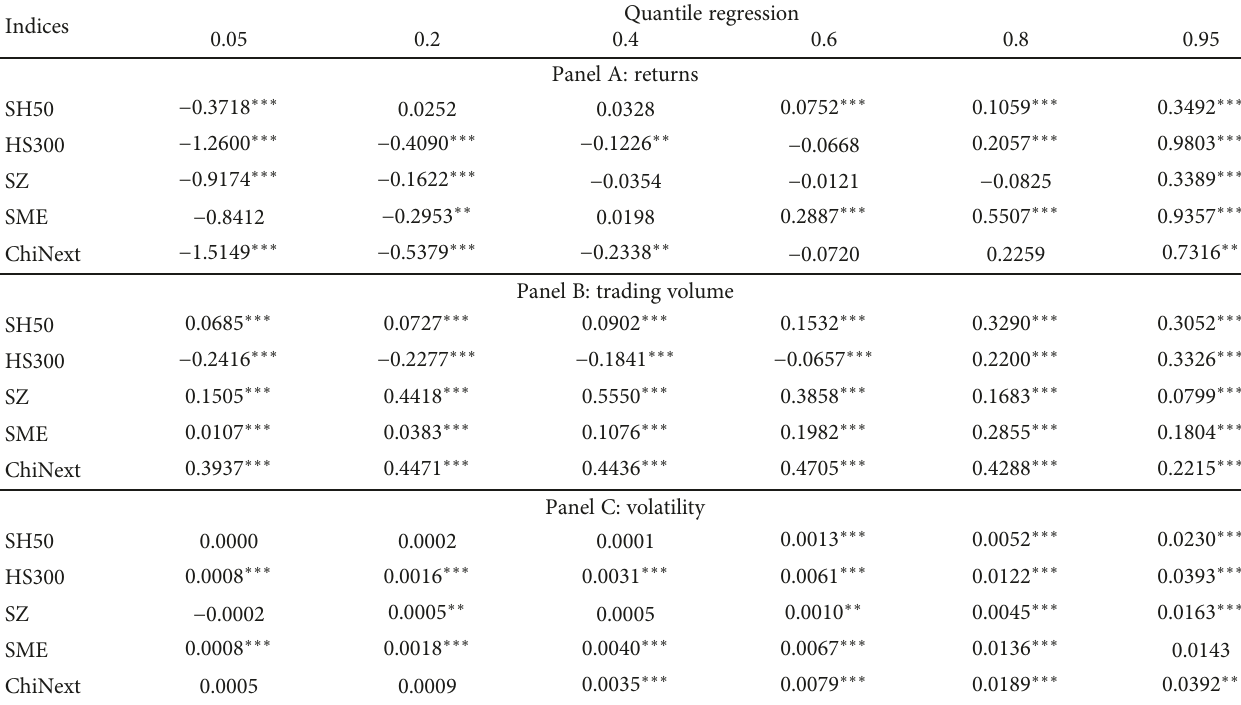
Table 4: Results for the quantile regression